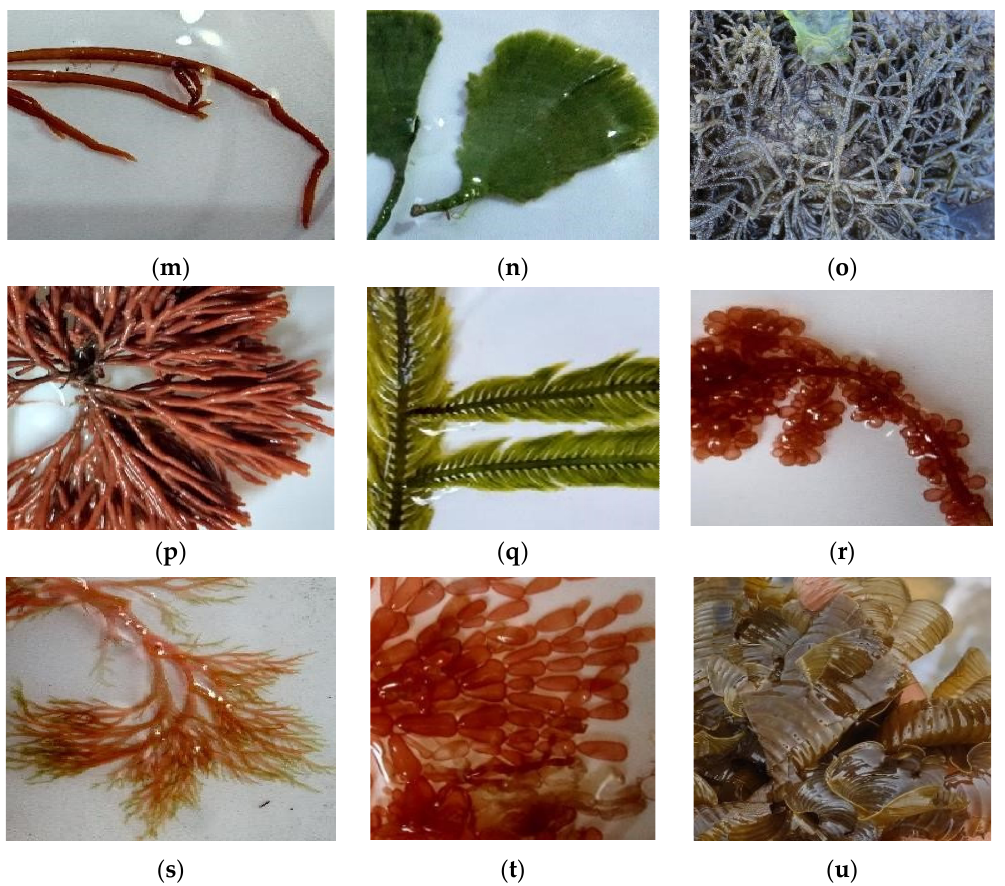
Figure 1. ( a – u ) Examples of marine macroalgae. ( a ) Chaetomorpha antennina (green); ( b ) Corallina sp. (red); ( c ) Sargassum linearifolium (brown); ( d ) Palisada perforata (red); ( e ) Sargassum cinereum ; ( f ) Palisada perforata (as Laurencia papillosa ); ( g ) Laurencia glandulifera (red); ( h ) Sargassum tenerrimum (brown); ( i ) Sargassum tenerrimum (brown); ( j ) Ulva lactuca (green); ( k ) Laurencia sp. (red); ( l ) Gracilaria sp. (red); ( m ) Gracilaria debilis (red); ( n ) Udotea indica (green); ( o ) Champia compressa (red); ( p ) Tricleocarpa fragilis (red); ( q ) Caulerpa taxifolia (green); ( r ) Botryocladia leptopoda (red); ( s ) Centroceras clavulatum (red); ( t ) Scinaia moniliformis (red); ( u ) Padina tetrastromatica